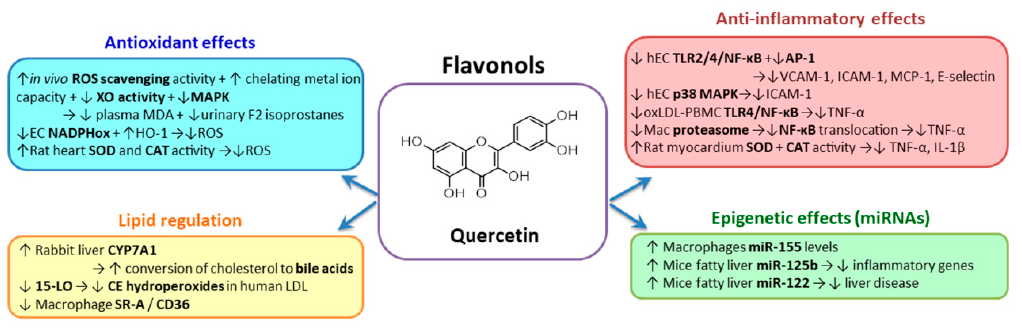
ff ects in the context of cardiovascular